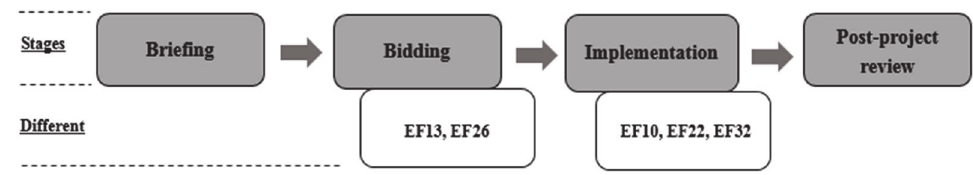
Figure 4. Different factors of the competition